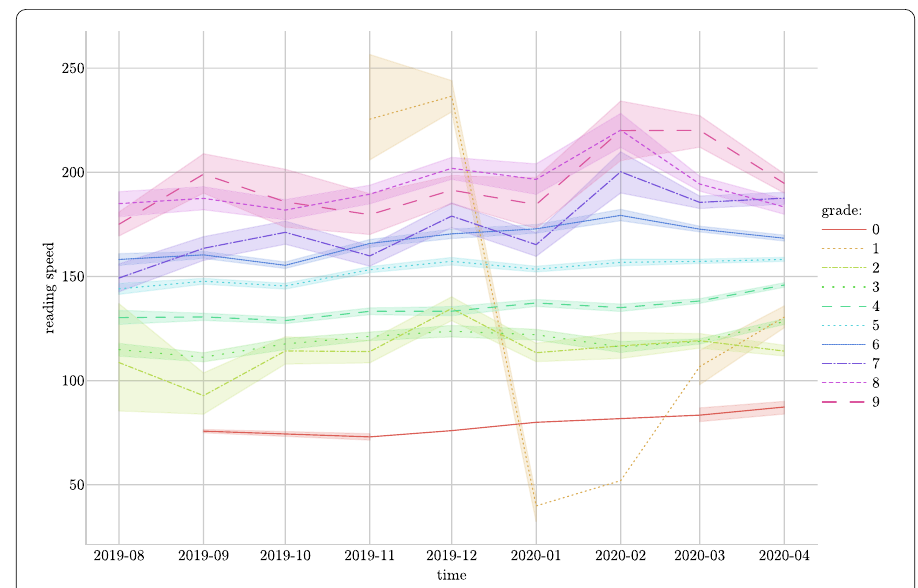
Figure 3 Reading speed over time per grade level. Regression line based on reading speed averages. With confidence